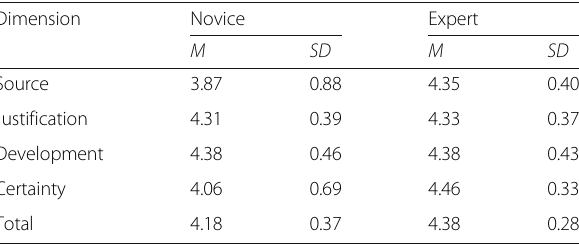
Table 3 Average and standard deviations for novice and expert scores on the scientific epistemic beliefs survey Dimension